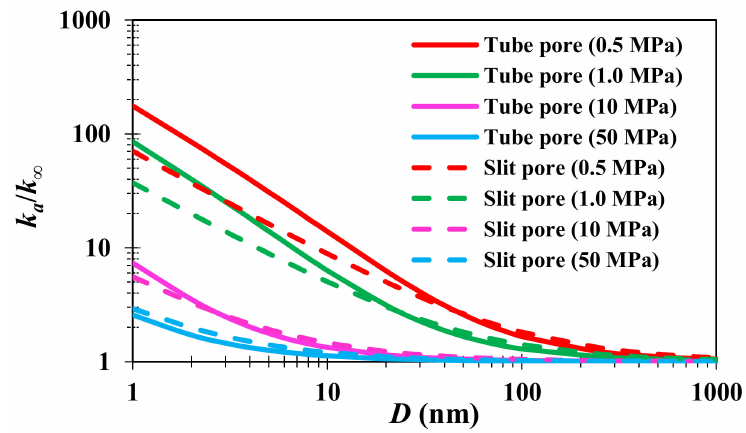
Figure 8. Ratios of apparent permeability to intrinsic